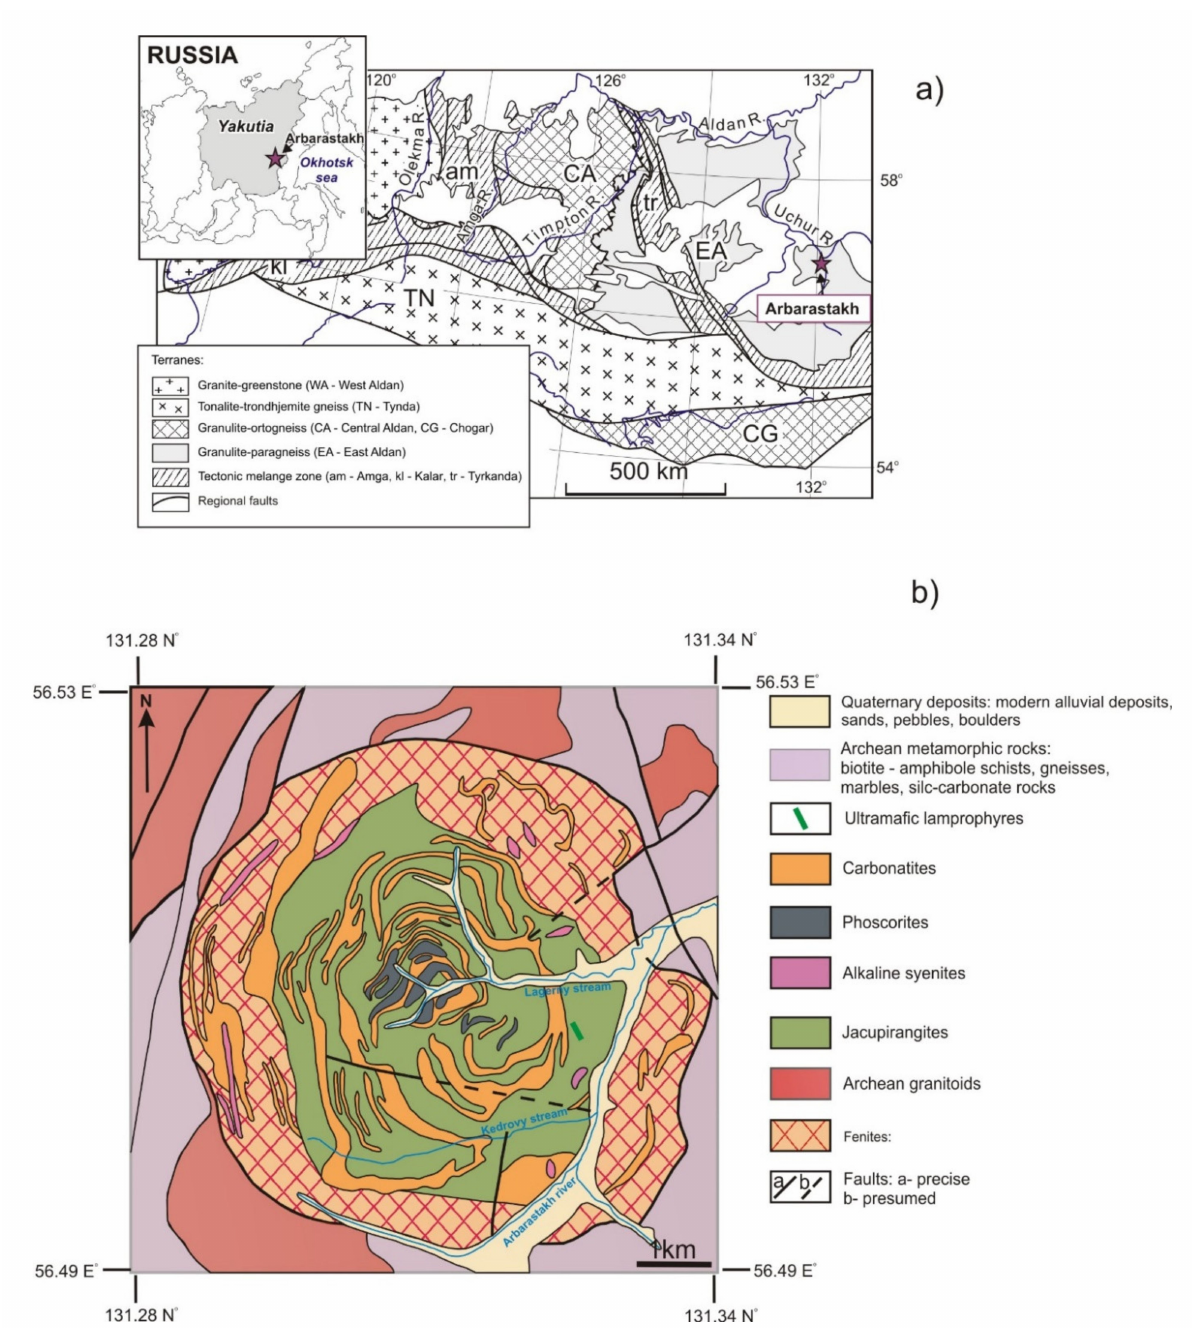
Figure 1. ( a ) Location of the ultramafic alkaline carbonatite complex Arbarastakh in Yakutia (Republic of Sakha), southeast of Russia (upper left inset) within the Aldan-Stanovoy shield (modified after [26]). ( b ) Scheme of the geological structure of the complex